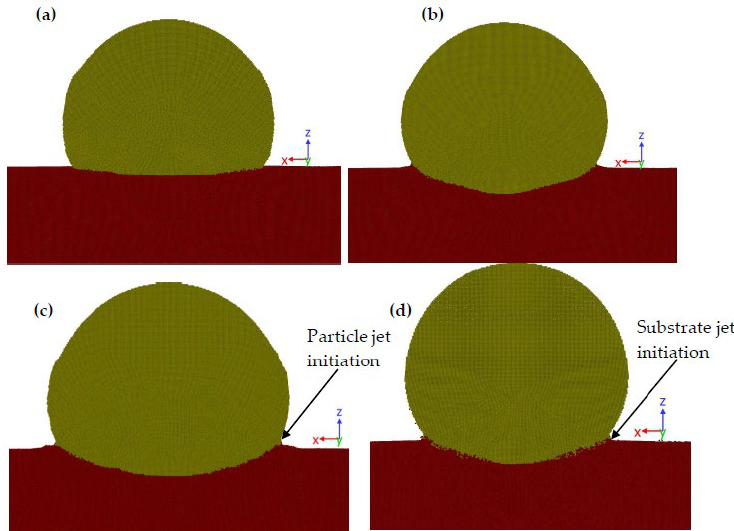
Figure 2. The pressure wave evolution at the periphery of the particle/substrate interfacial region at 1000 m/s of single-particle impact.